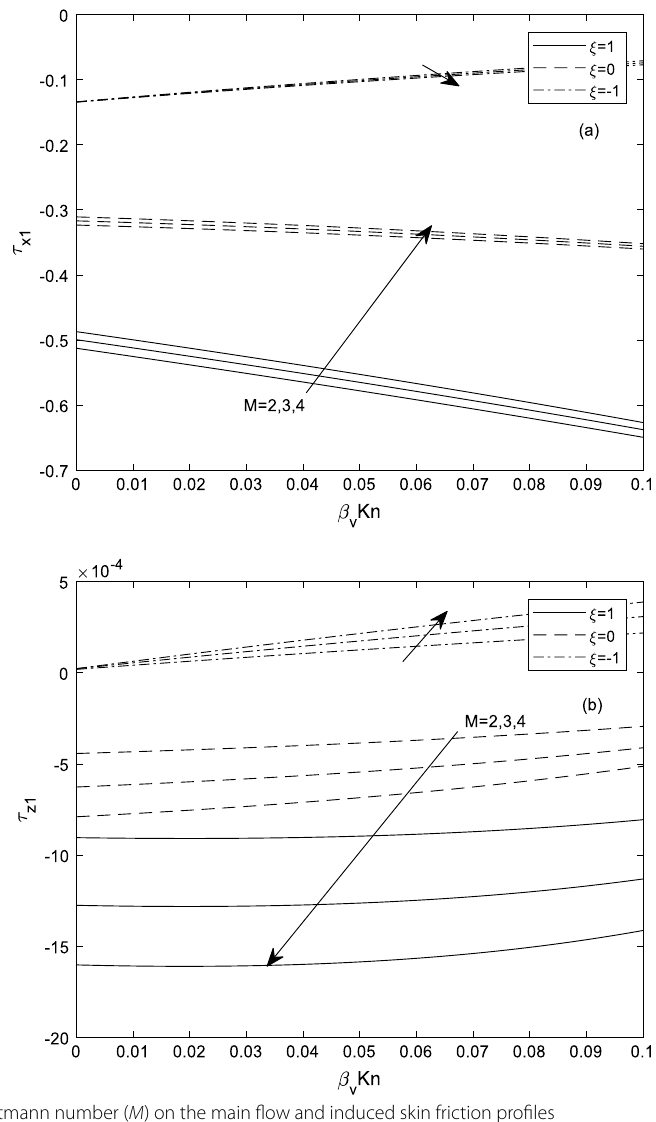
Fig. 9 a Hartmann number ( M ) on the main flow and induced skin friction profiles at y = 1 , for β v Kn = 0.05, M = 2,ln = 1.667, β h = 0.5, β i = 3.0 and Pr = 0.71 . b Hartmann number ( M ) on the main flow and induced skin friction profiles at y = 1 , for β v Kn = 0.05, M = 2,ln = 1.667, β h = 0.5, β i = 3.0 and Pr =